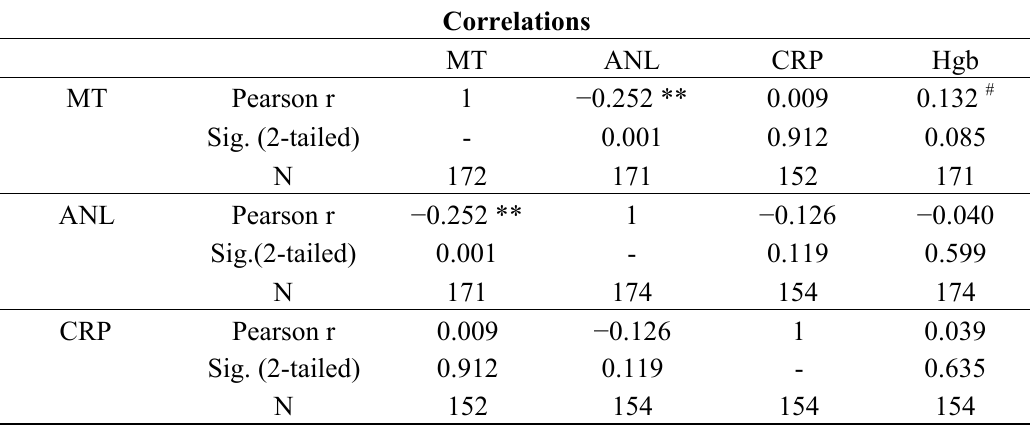
Table 1. Correlations between laboratory